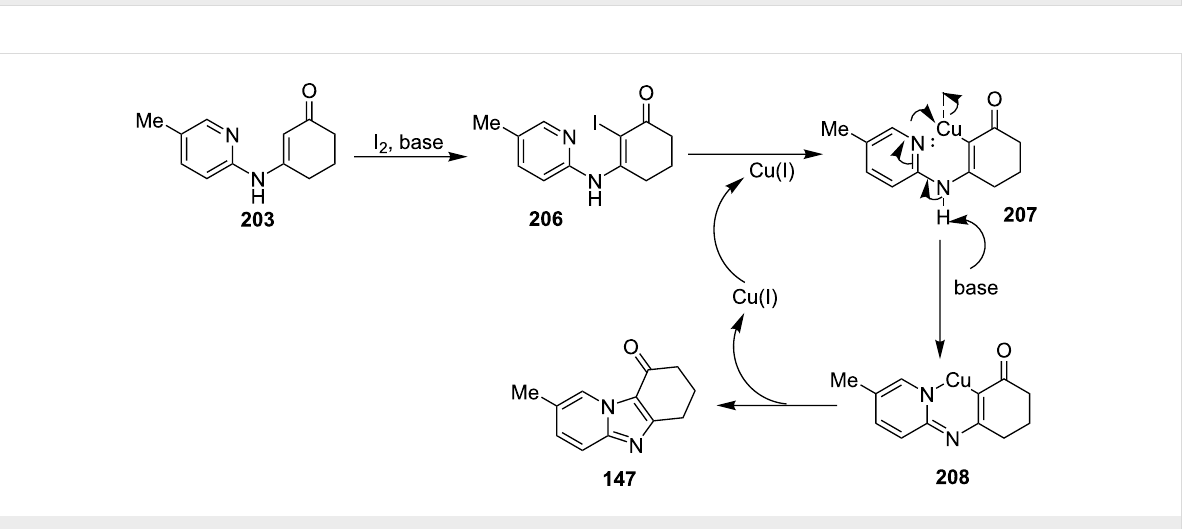
Scheme 71: C–H functionalization reaction of enamines to produce diversified heterocycles.